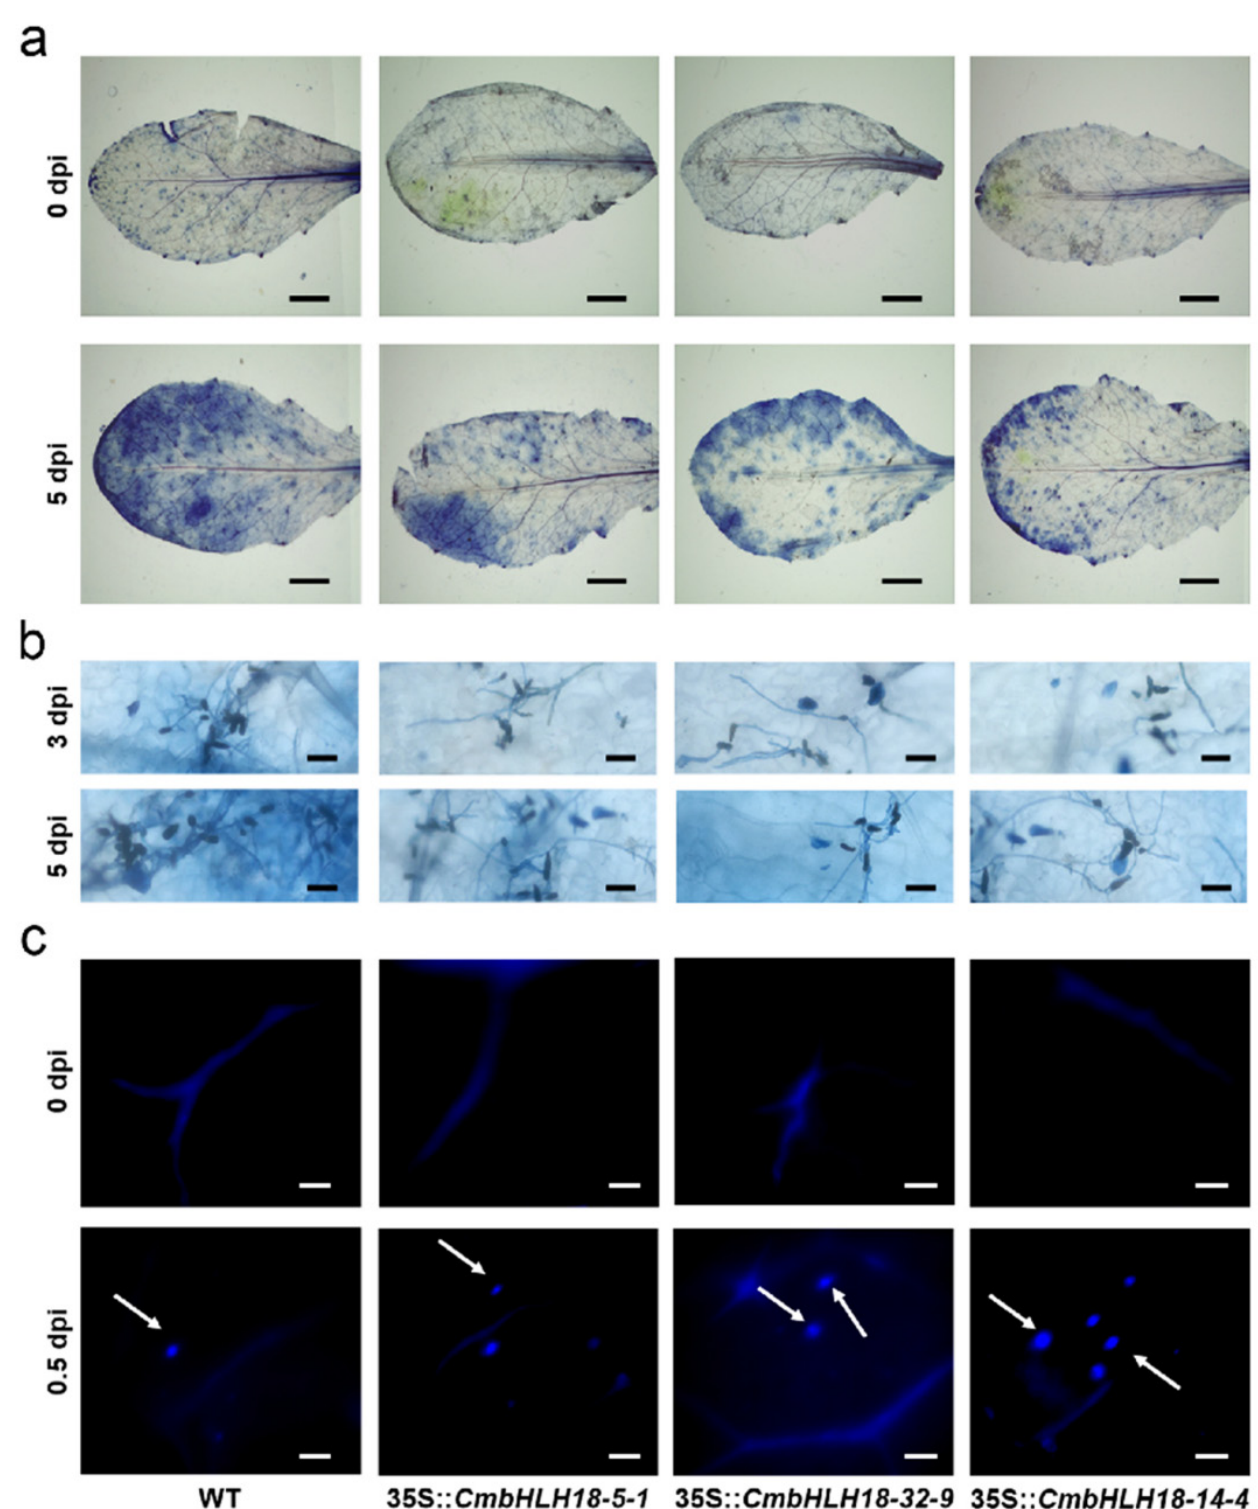
Figure 5. Effect of CmbHLH18 on the cell activity of leaves, growth of fungi, and callose deposition of leaves in Arabidopsis after inoculation with A. brassicicola . ( a ) Microscopic visualization of necrotic cells in leaves (Bar = 1 cm); ( b ) observation of fungi growth (Bar = 50 μ m); ( c ) Detection of callose deposition in leaves (Bar = 100 μ m).